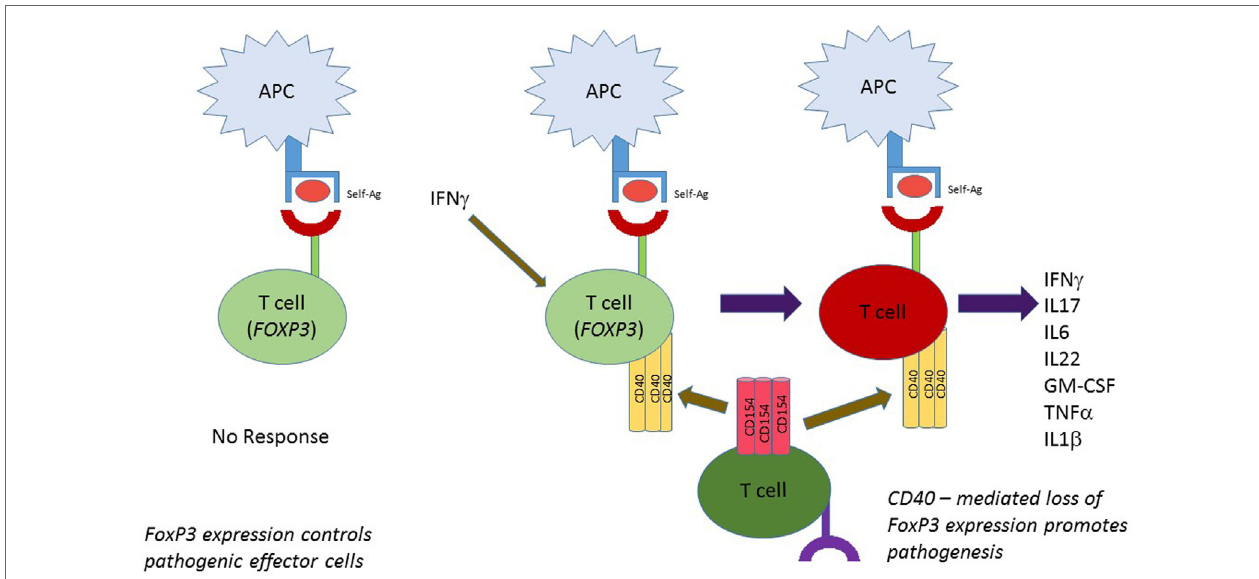
FiGURe 2 | FOXP3 as a static T cell regulator independent of Treg status. Cells other than classic Tregs express FOXP3. In the BDC2.5 T cell receptor transgenic mouse model effector, T cells express FOXP3 but in the inflammatory environment where IFN γ , etc., is produced, CD40 is induced on those cells. CD40 interaction with CD154 leads to loss of FOXP3 expression and full effector